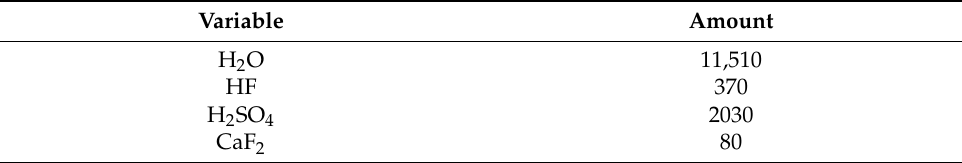
Table 5. Certain reagents that end in the treatment waste unit (in